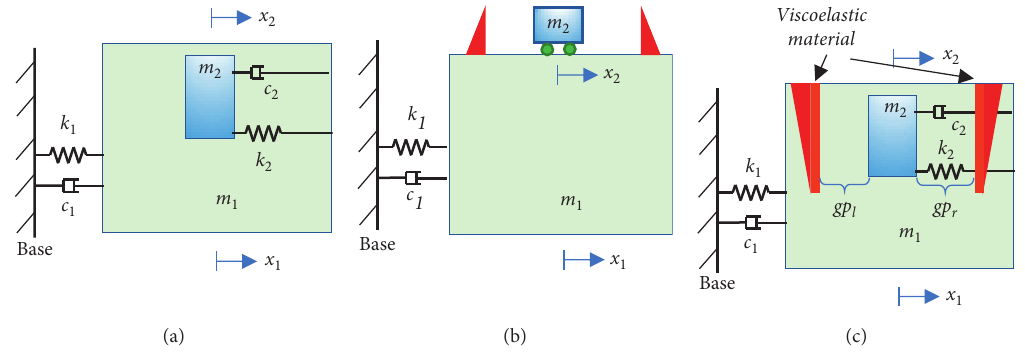
Figure 3: : Schematics of (a) TMD, (b) impact damper, and (c) PTMD.